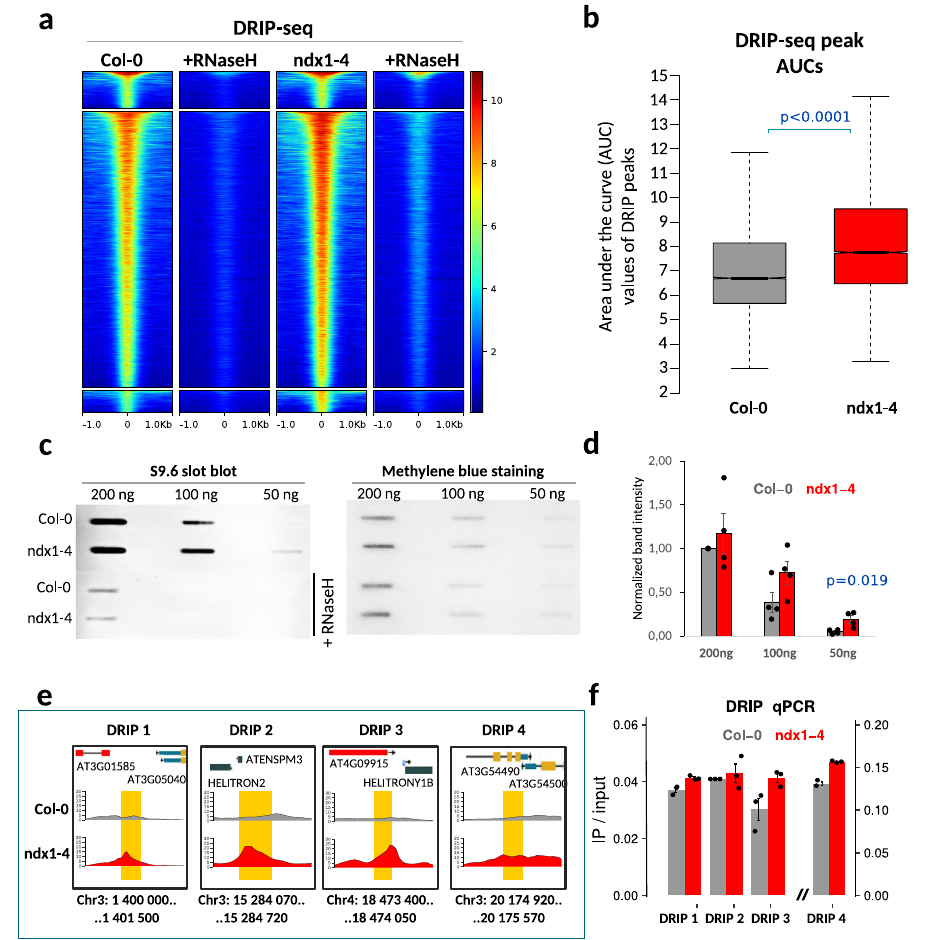
ndx1 – 4 plants. c Detection of RNA-DNA hybrids in Col-0 and ndx1 – 4 plants using slot blot hybridization. 200ng, 100ng, and 50ng of gDNA were slotted onto a nitrocellulose membrane with and without RNase H-treatment, stained with S9.6 antibody and goat anti-mouse-HRP secondary antibody. Equal loading was deter- mined by methylene blue staining. d Band intensities were quanti fi ed by ImageJ (average values are shown). Error bars: SD. Statistics: Student ’ s t test, two-sided. Sample size n =3 biologically independent replicates. e , f Genome browser tracks andDRIP-qPCRvalidationofDRIPpeaksidenti fi edinCol-0(red)and ndx1 – 4 (blue) samples. Error bar: SEM. Sample size n =2 biologically independent